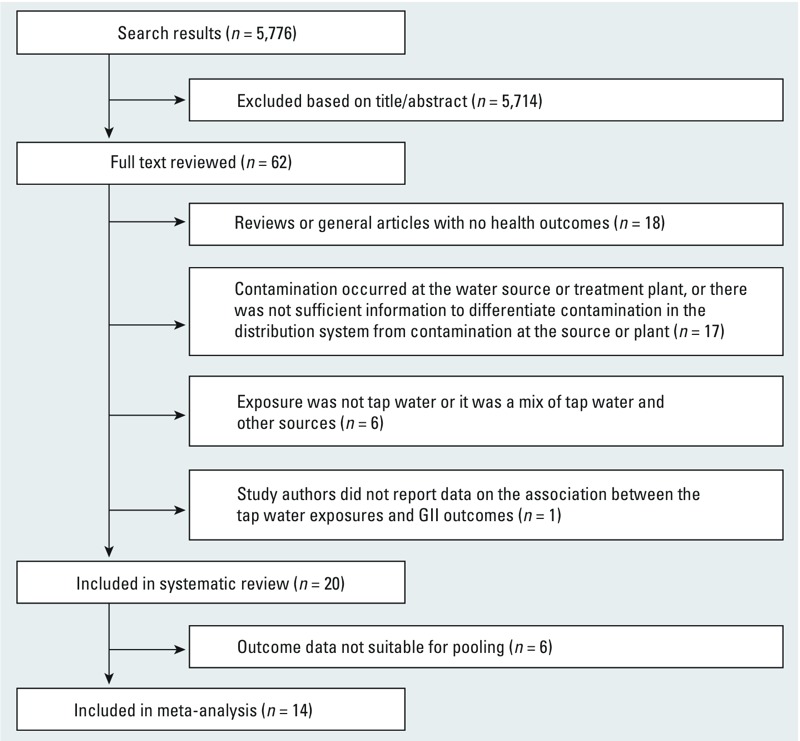
Flow chart showing inclusion and exclusion of articles. The number of search results reflects the omission of 469 duplicate citations from the total of 6,245.